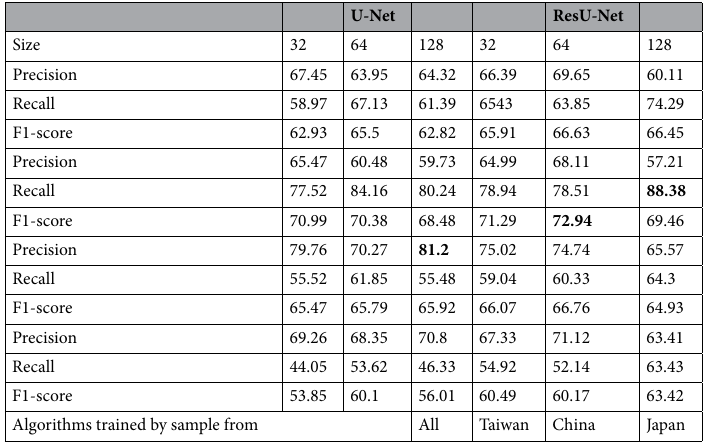
Table 4. The resulting precision, recall, and f1-score values for Scenario 1 (training the algorithms with all training datasets and testing them on the Taiwan, China, Japan, and all test datasets separately). The highest values of precision, recall, and f1-score are indicated in